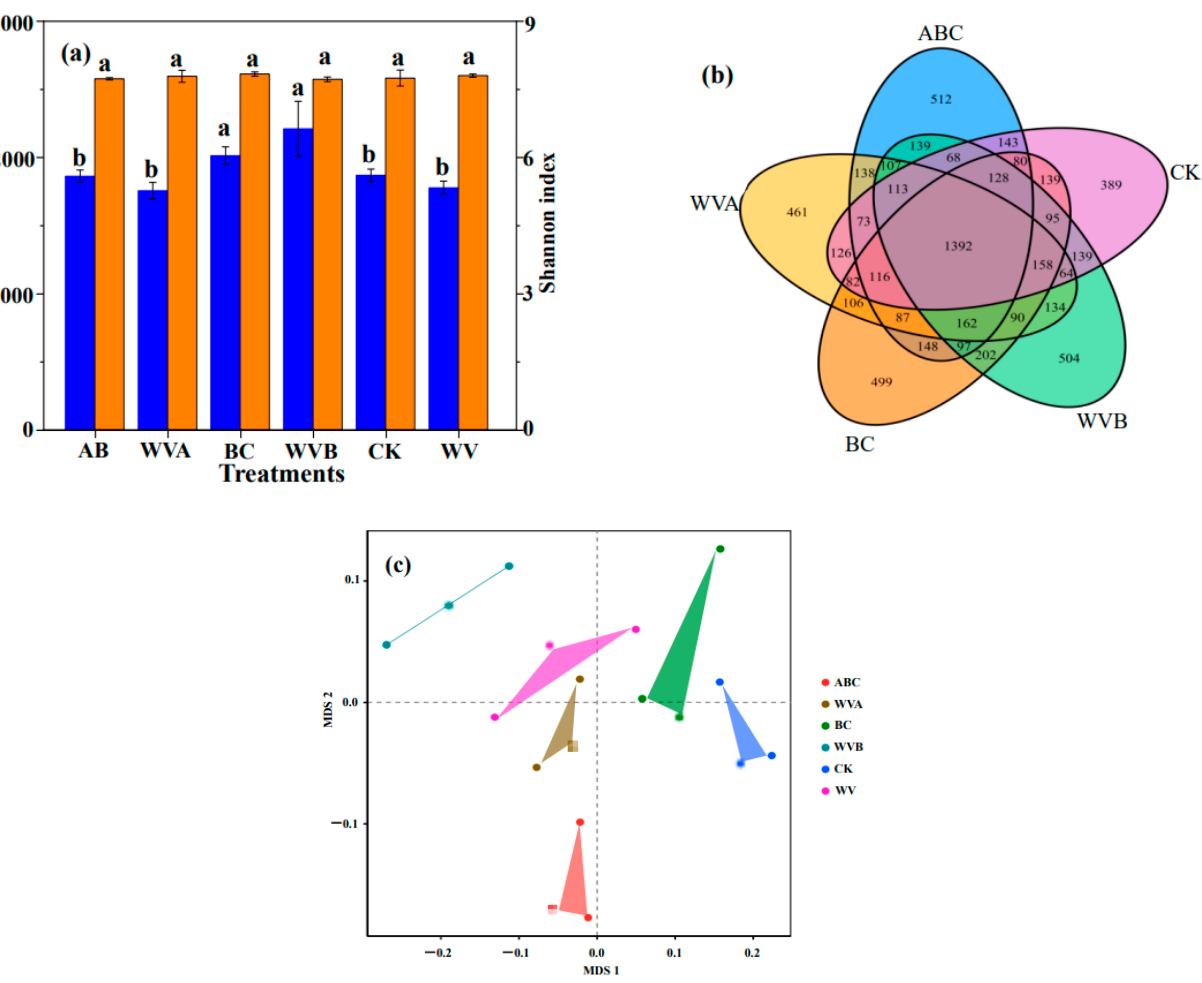
Figure 5. Profiles of the bacterial community in the coastal saline–alkali soil with different treatments. ( a ) The richness (Chao1) and diversity (Shannon) index for the soil bacterial community. ( b ) Venn diagram showed the shared bacterial OTUs. ( c ) Non-metric multidimensional scaling (NMDS) ordination plots of bacterial community composition based on Bray–Curtis similarity. The different letters among different treatments indicate significant differences, which were analyzed by Duncan’s test ( p = 0.05).